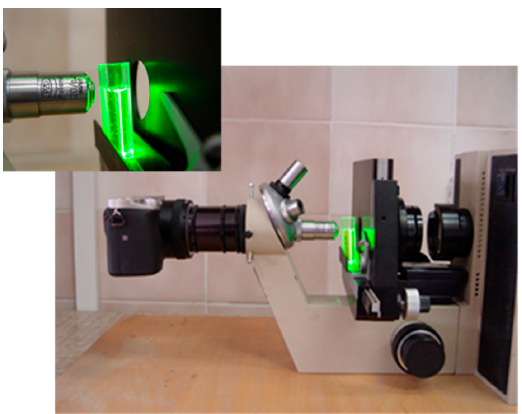
Figure 1. Self-made measurement system for the observation of laser light scattering.